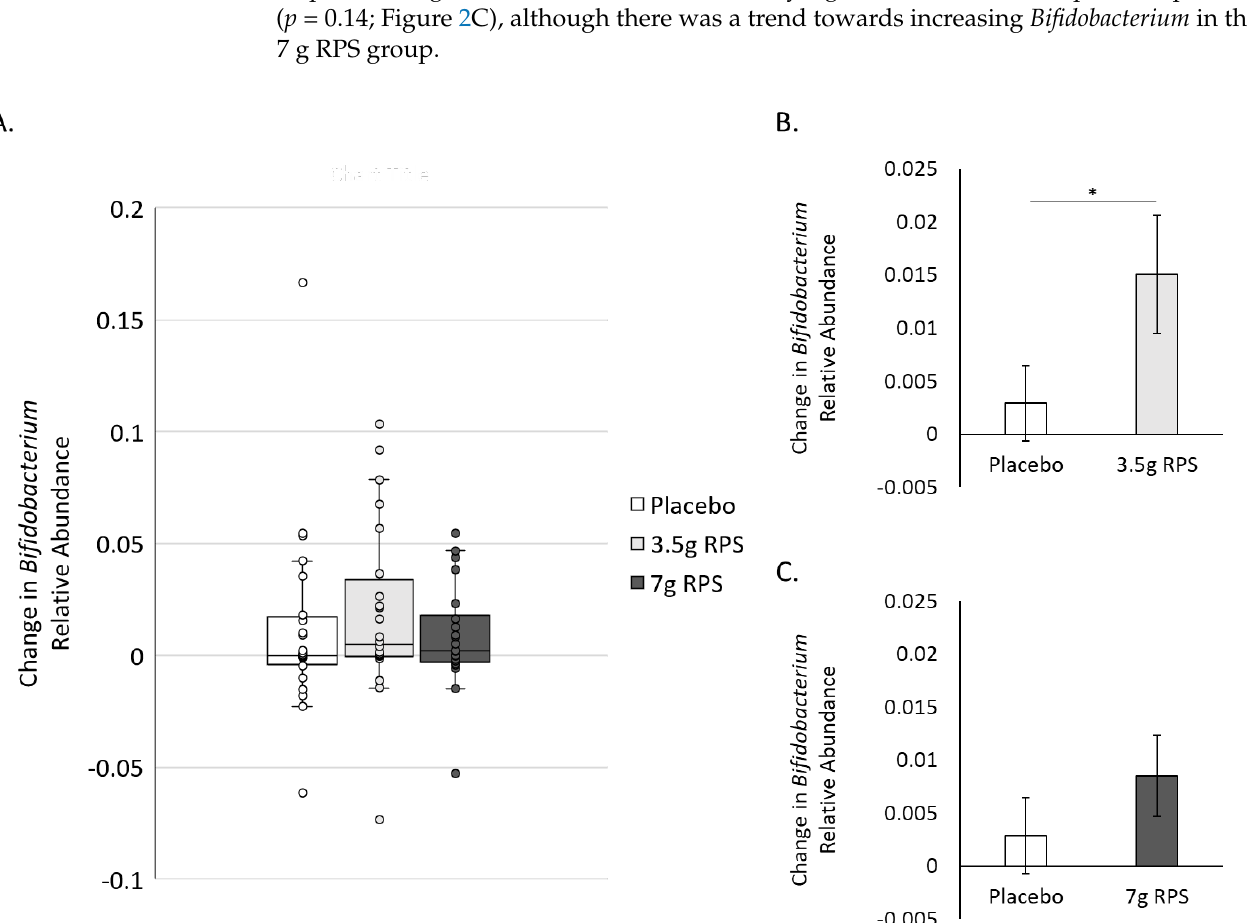
Figure 2. Increases in the relative abundance of Bifidobacterium after 4 weeks in response to placebo, 3.5 g RPS, or 7 g RPS. ( A ) Box and whisker plots revealing interquartile range (IQR; box), median (line inside box), and 1.5 times the IQR (error bars), as well as individual data points (circles). ( B ) The increase in the relative abundance of Bifidobacterium was significantly higher in the 3.5 g RPS group compared to the placebo arm ( p = 0.038). ( C ) The increase in the relative abundance of Bifidobacterium was not significantly higher in the 7 g RPS group ( p = 0.14) compared to the placebo arm (Student’s t -test, * p < 0.05).